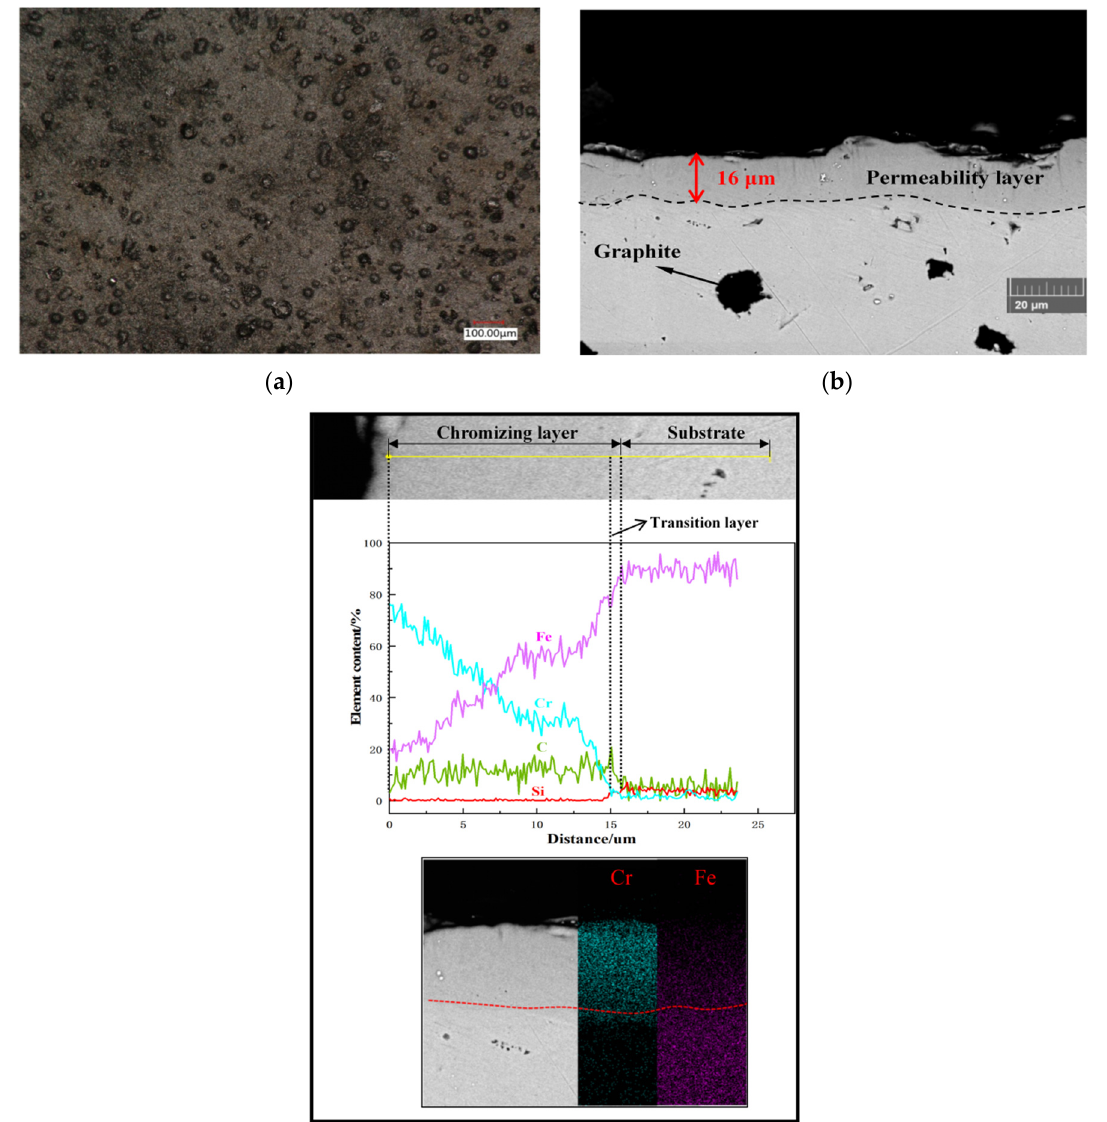
Figure 2. SEM micrographs of chrome coating and chemical-composition distribution of the coating in cross-section. ( a ) Chromed coating surface (2000×). ( b ) Chromed layer (5000×). ( c ) Composition distribution of the sample in cross-section.